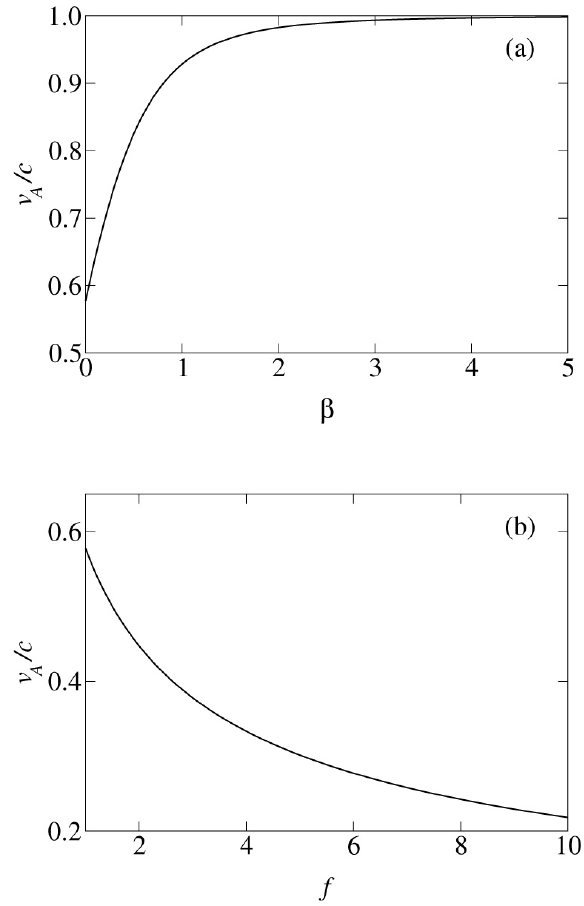
Fig. 5. Alfvén velocity, Eq. (30), for α = 0 . 1, v A 0 = 1. (a) For fixed temperature, f = 1, as a function of the drift velocity β . (b) For fixed drift velocity, β = 0, as a function of temperature, parameteri- zed by f